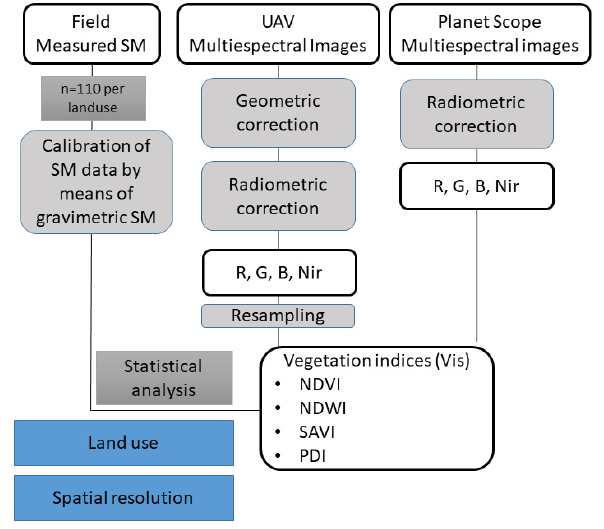
Figure 2. Workflow of the pursued methodology. R (Red), G (Green), B (Blue), NIR (Near Infra-Red). Source: Current research. Table 1. Soil profile descriptions and associated hydrological and pedological variables. Kfs: field ‐ saturated soil hydraulic conductivity.